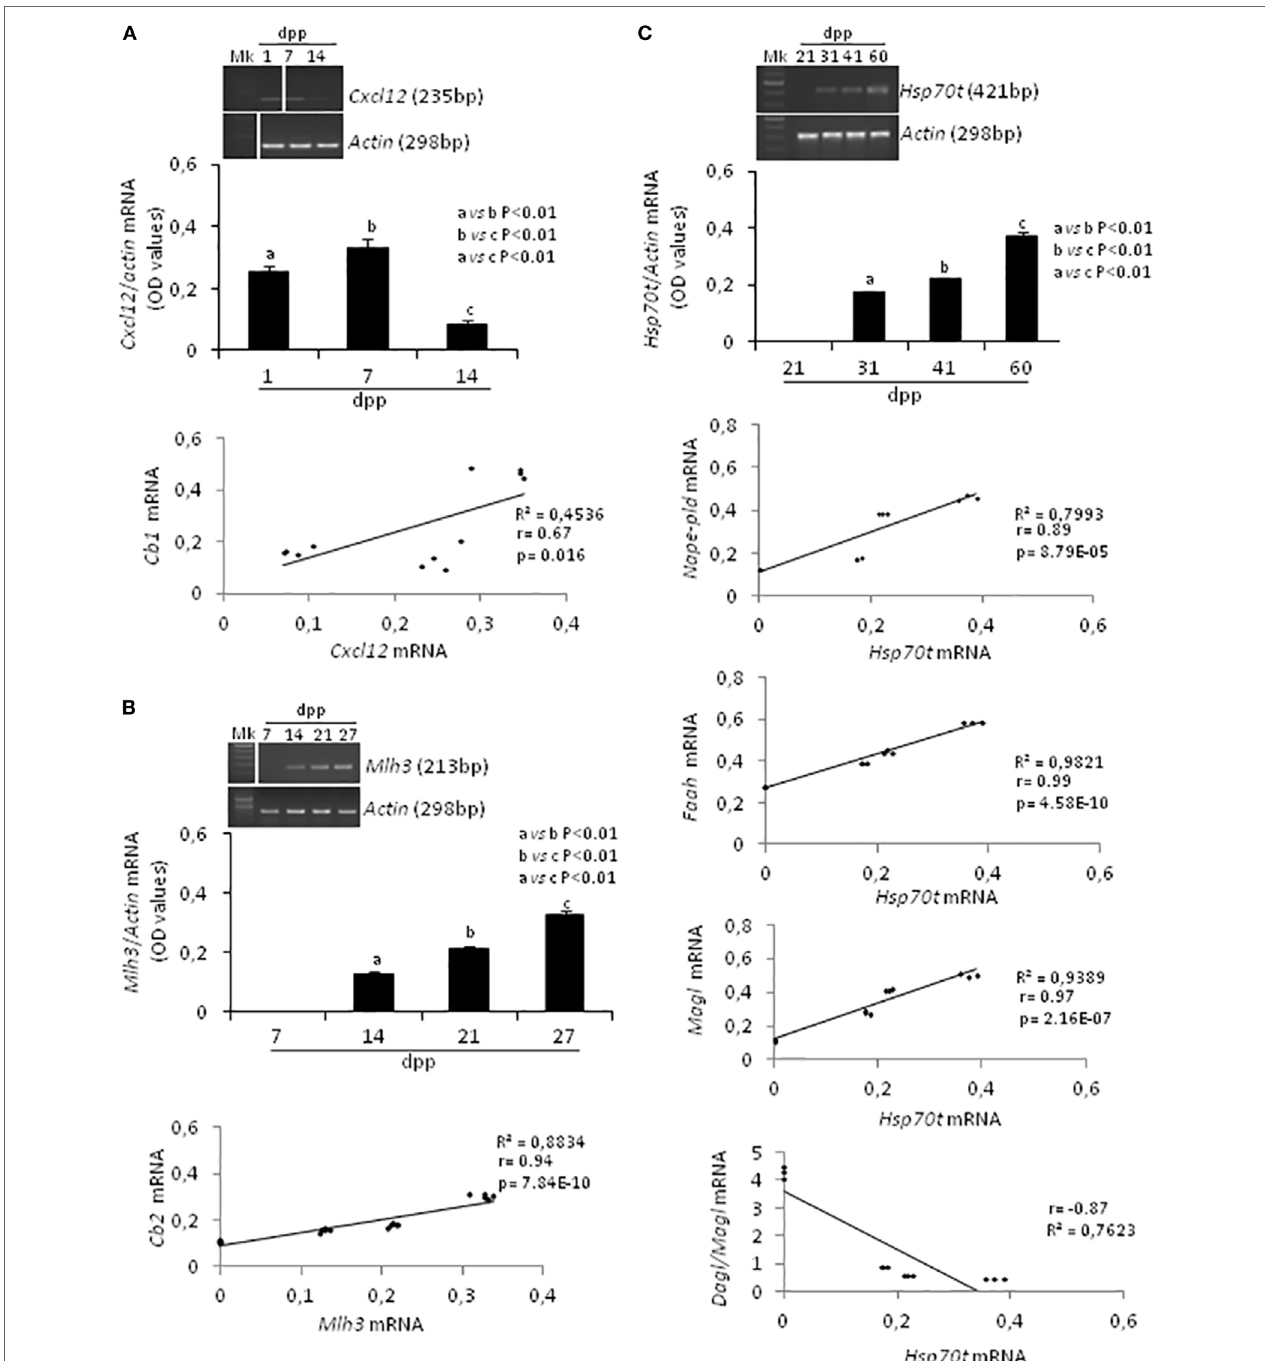
FigUre 3 | RT-PCR analyses of specific markers related to the activity and/or presence of germ cells at specific times during the first spermatogenetic wave and relative correlation analyses. Representative images of RT-PCR analyses showing Cxcl12 and Actin mRNA expression in rat testis from 1 to 14 days post partum ( dpp ). Cxcl12 expression was quantified by densitometry analysis and normalized against Actin signals. Values, expressed as OD have been used for correlation analysis between Cxcl12 and Cb1 mRNA expression (a) . Representative images of RT-PCR analyses showing Mlh3 and Actin mRNA expression in rat testis from 7 to 27 dpp . Mlh3 expression was quantified by densitometry analysis and normalized against Actin signals. Values, expressed in OD, have been used for correlation analysis between Mlh3 and Cb2 mRNA expression (B) . Representative images of RT-PCR analyses showing Hsp70t and Actin mRNA expression in rat testis from 21 to 60 dpp . Hsp70t expression was quantified by densitometry analysis and normalized against Actin signals. Values, expressed as OD, have been used for correlation analysis between Hsp70t and Nape-pld or Faah or Magl or Dagl / Magl mRNA expression (c) . Different letters indicate statistically significant differences ( p < 0.01). The white bars in the agarose gel images indicate cropped figures from same gel.